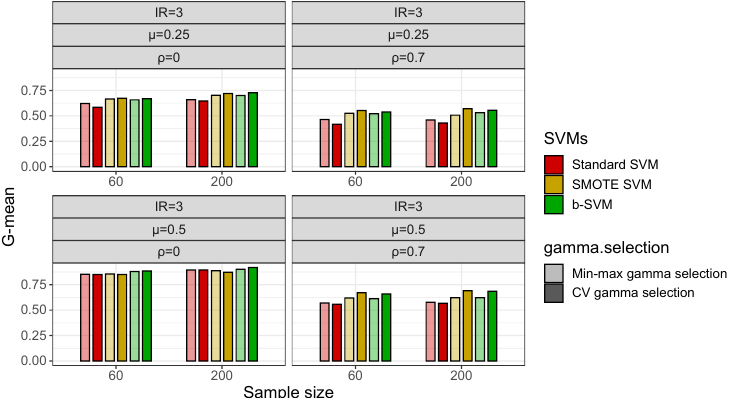
Figure 4. Classification performance (G-mean) of SVMs using different gamma selections in simulated low-dimensional datasets with IR = 3.